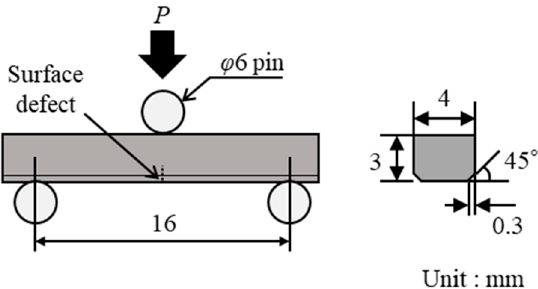
Figure 4. Schematic diagram of the three-point loading system and size and dimensions of test specimen.